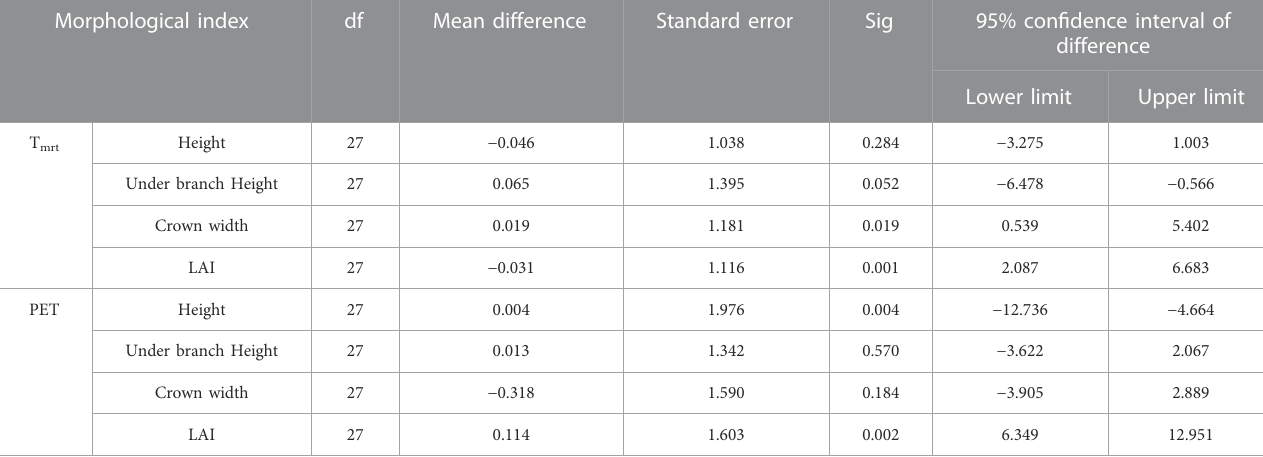
TABLE 6 Signi fi cance analysis of different morphological indexes of arbors on T mrt and PET. Morphological